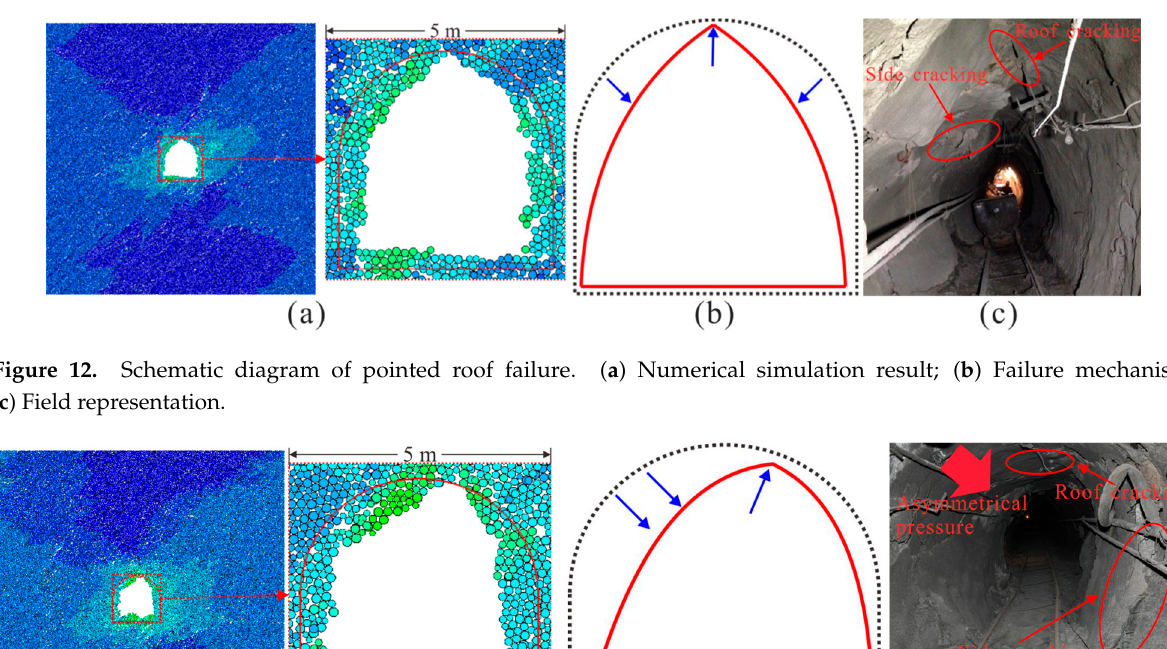
Figure 13. Schematic diagram of peach-shaped failure. ( a ) Numerical simulation result; ( b ) Failure mechanism; ( c ) Field